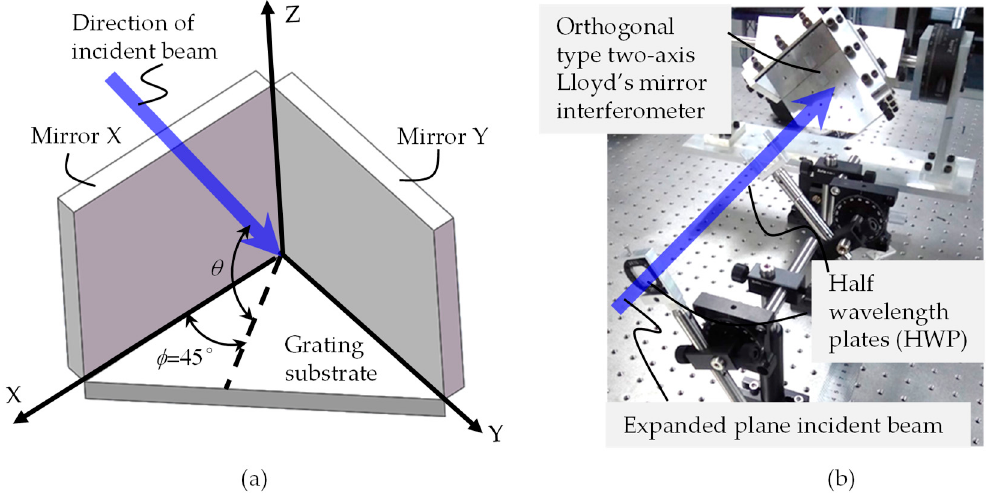
Figure 2. The global coordinate system of exposure system. ( a ) Two-axis Lloyd’s mirror unit and definition of incident angle θ and azimuth angle ϕ . ( b ) Photograph of half-wavelength plates (HWPs) setup.